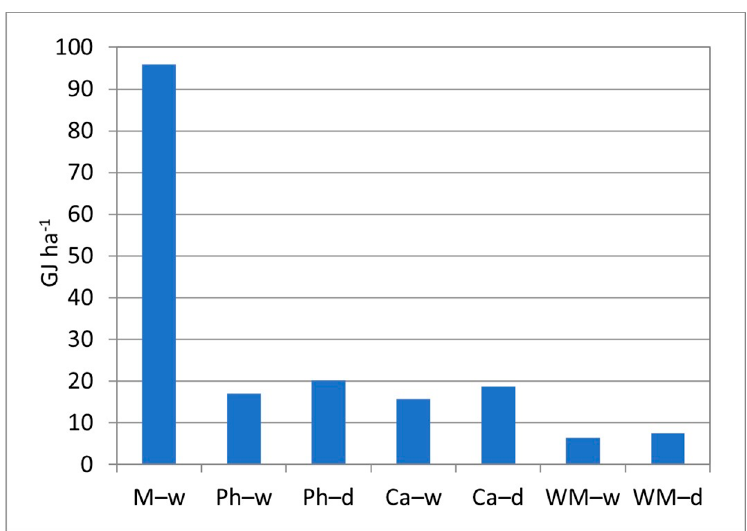
Figure 2. Energy density of analyzed feedstocks. M–w—wet fermentation of maize, Ph–w—wet